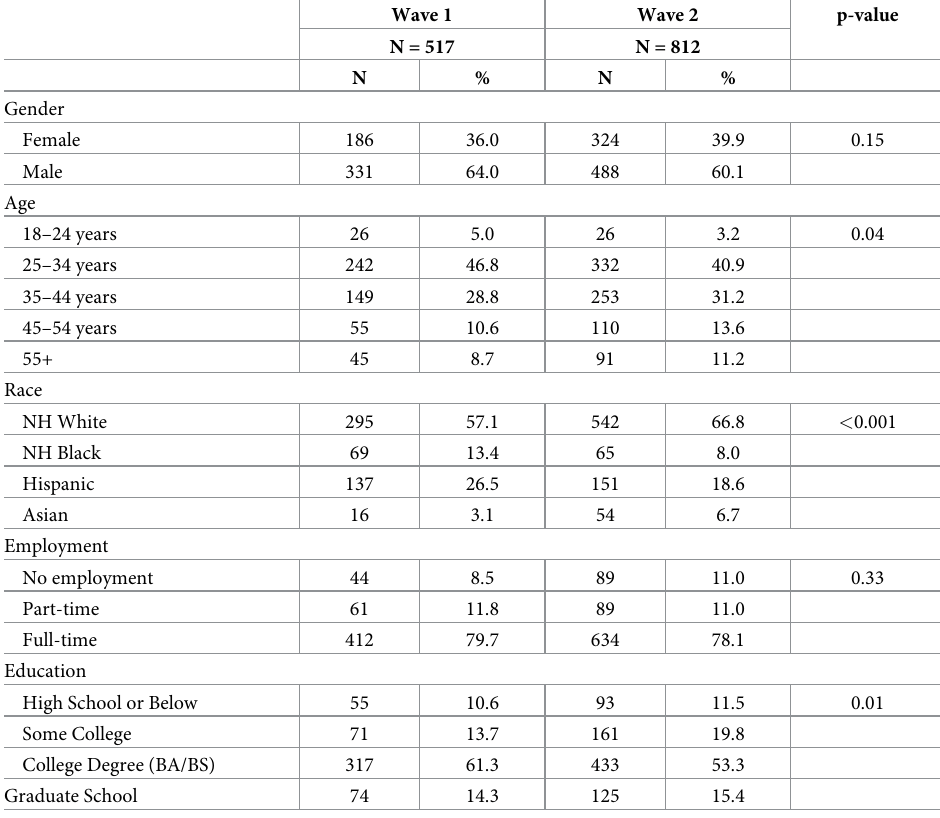
Table 2. Sample characteristics for Waves 1 (N = 517) and 2 (N =